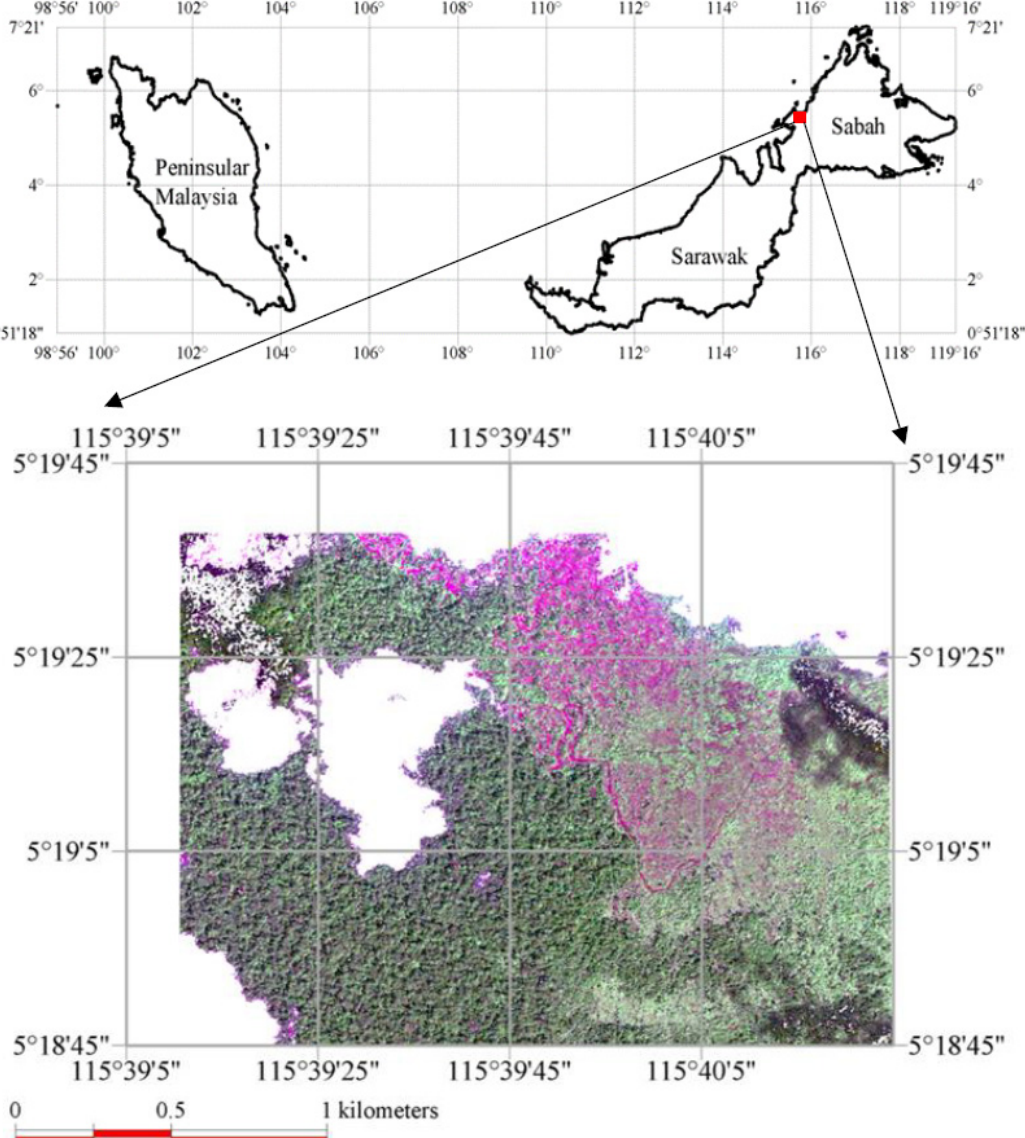
Figure 1. Location of the Klias Forest Reserve (red box in the upper figure) and the QuickBird image for the study site. The irregular path in reddish pink is the fire barrier established using a tractor in 2003 to stop the fire spread.